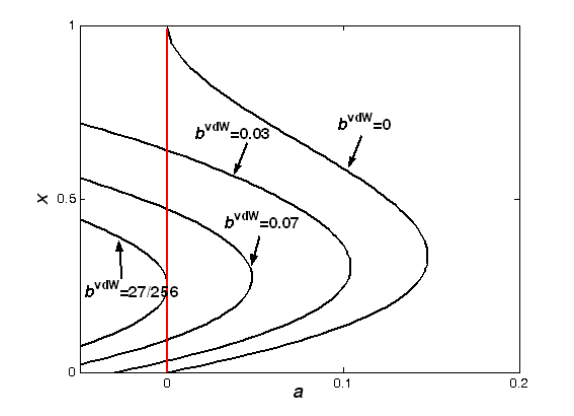
Figure 7. Variation of equilibrium points with parameter a for different parameter vdW b with vdW